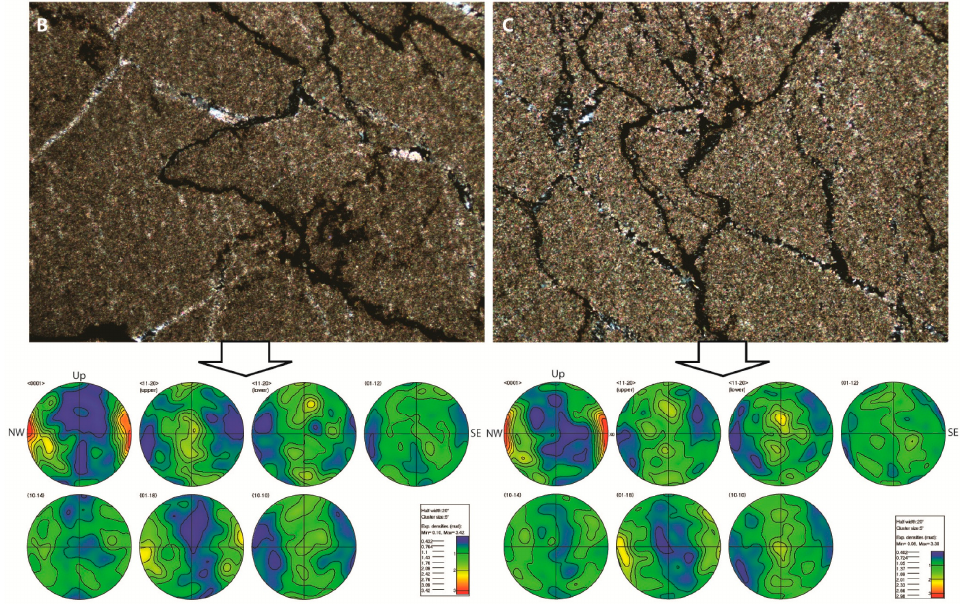
Figure 6. Photomicrograph of calcareous siltstone in the Martinsburg Fm. ( A : polarized light) with yellow rectangles indicating areas of EBSD analysis ( B and C ) and lower hemisphere pole figure calcite results below (n = 202 for each area, A and B).